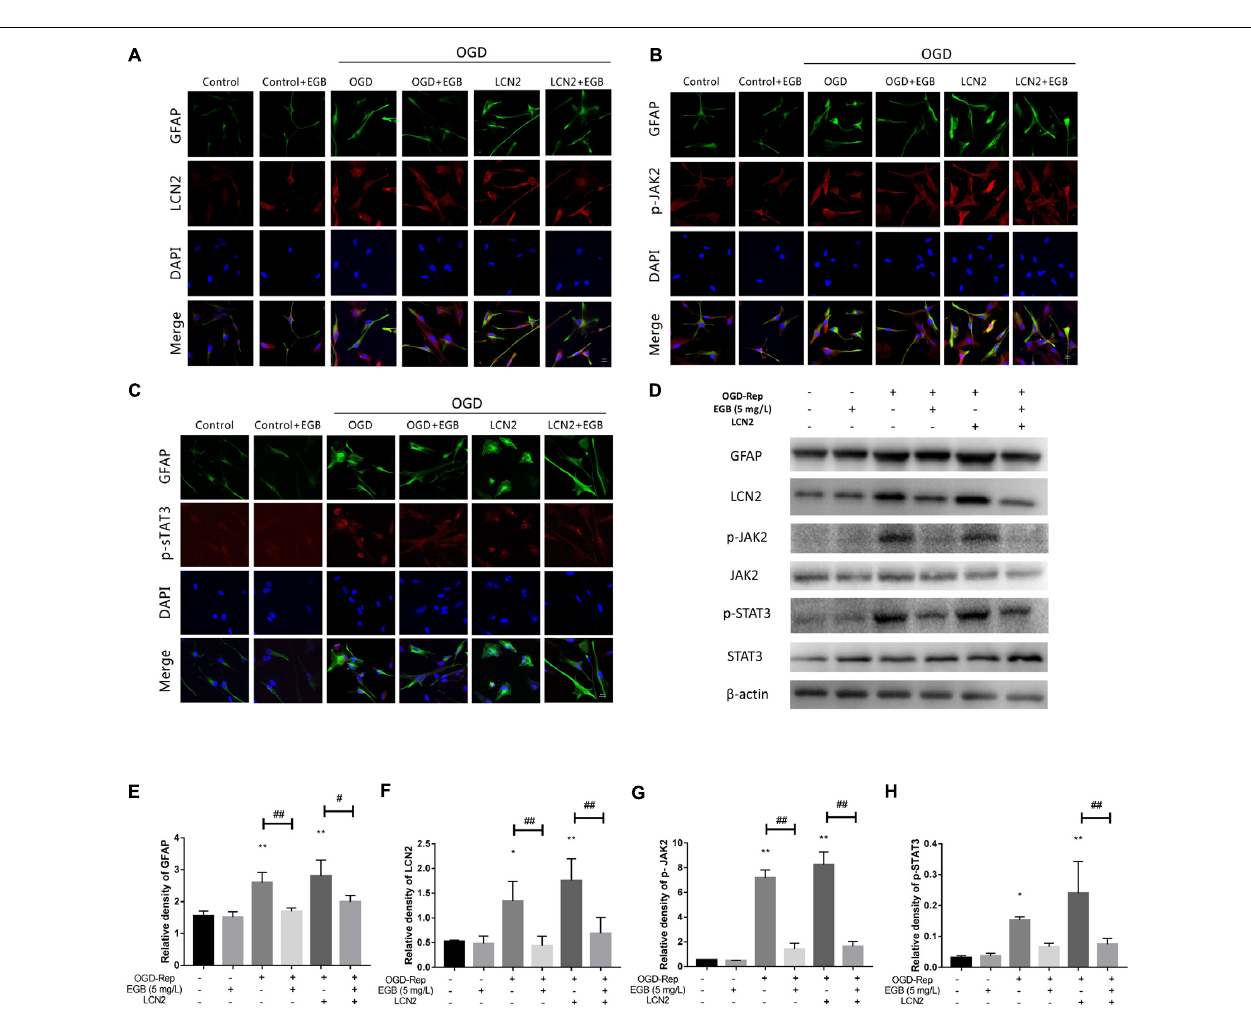
Frontiers in Pharmacology |